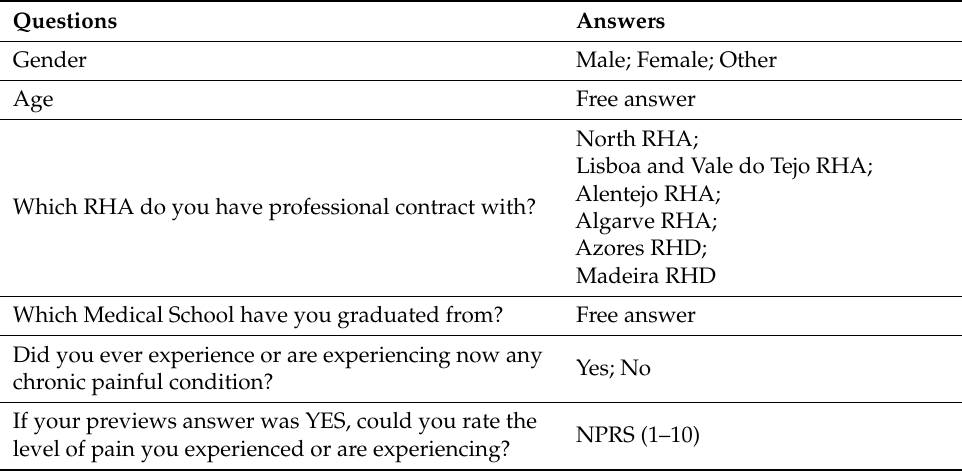
Table 1. General Characterization